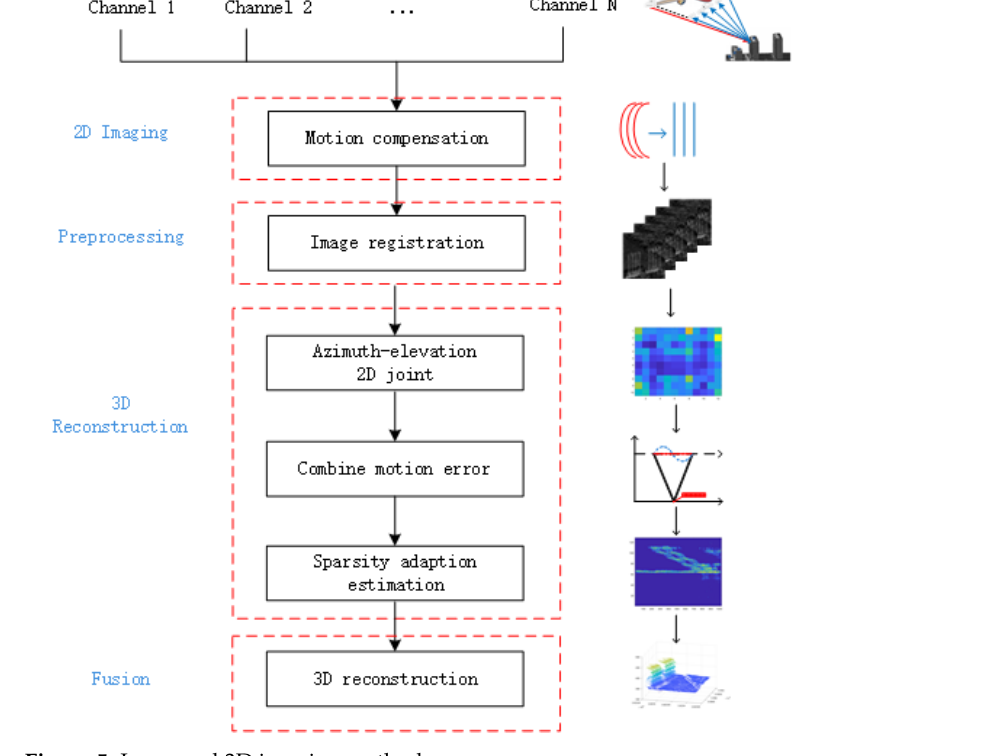
Figure 5. Improved 3D imaging method. Algorithm 1: 3D